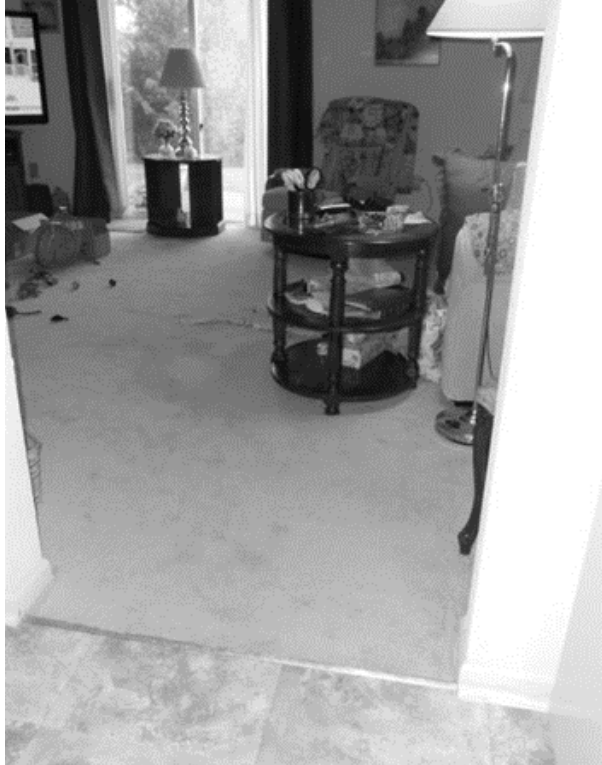
Figure 1. The path of Participant 2’s near fall.